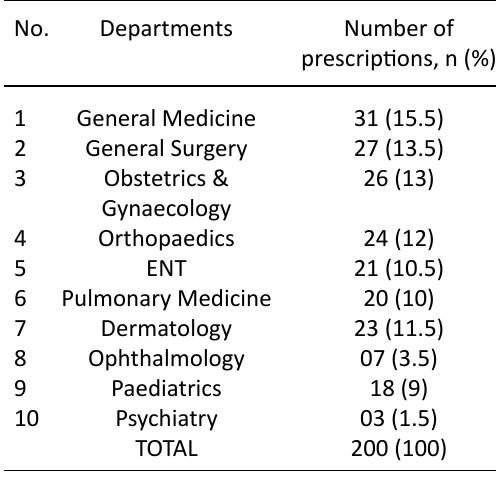
Table 1. Department wise distribution